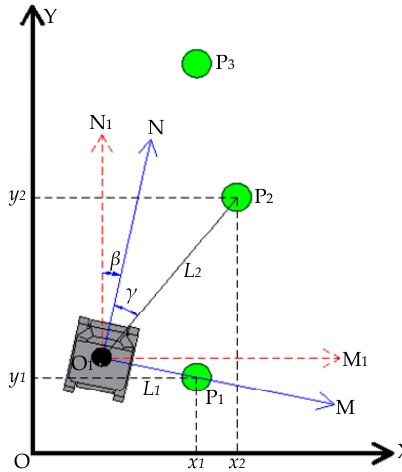
Figure 10. The transformation of a tree’s coordinates.